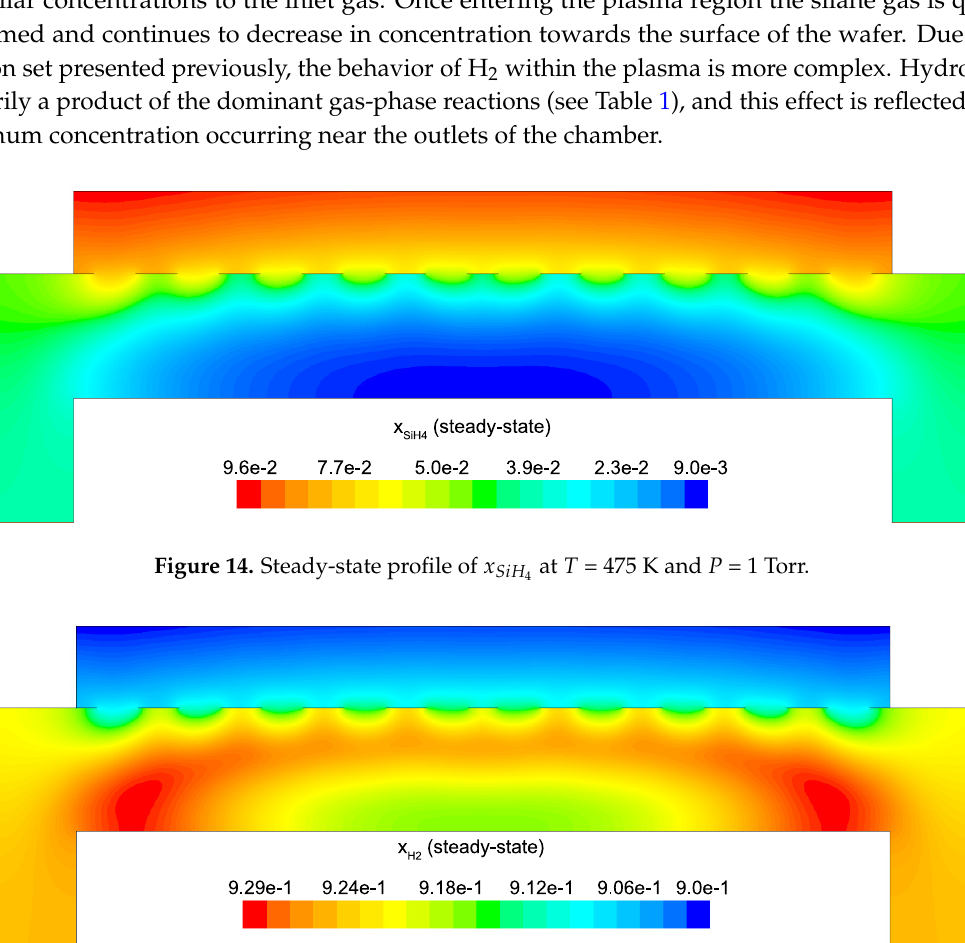
at T = 475 K and P = 1 2